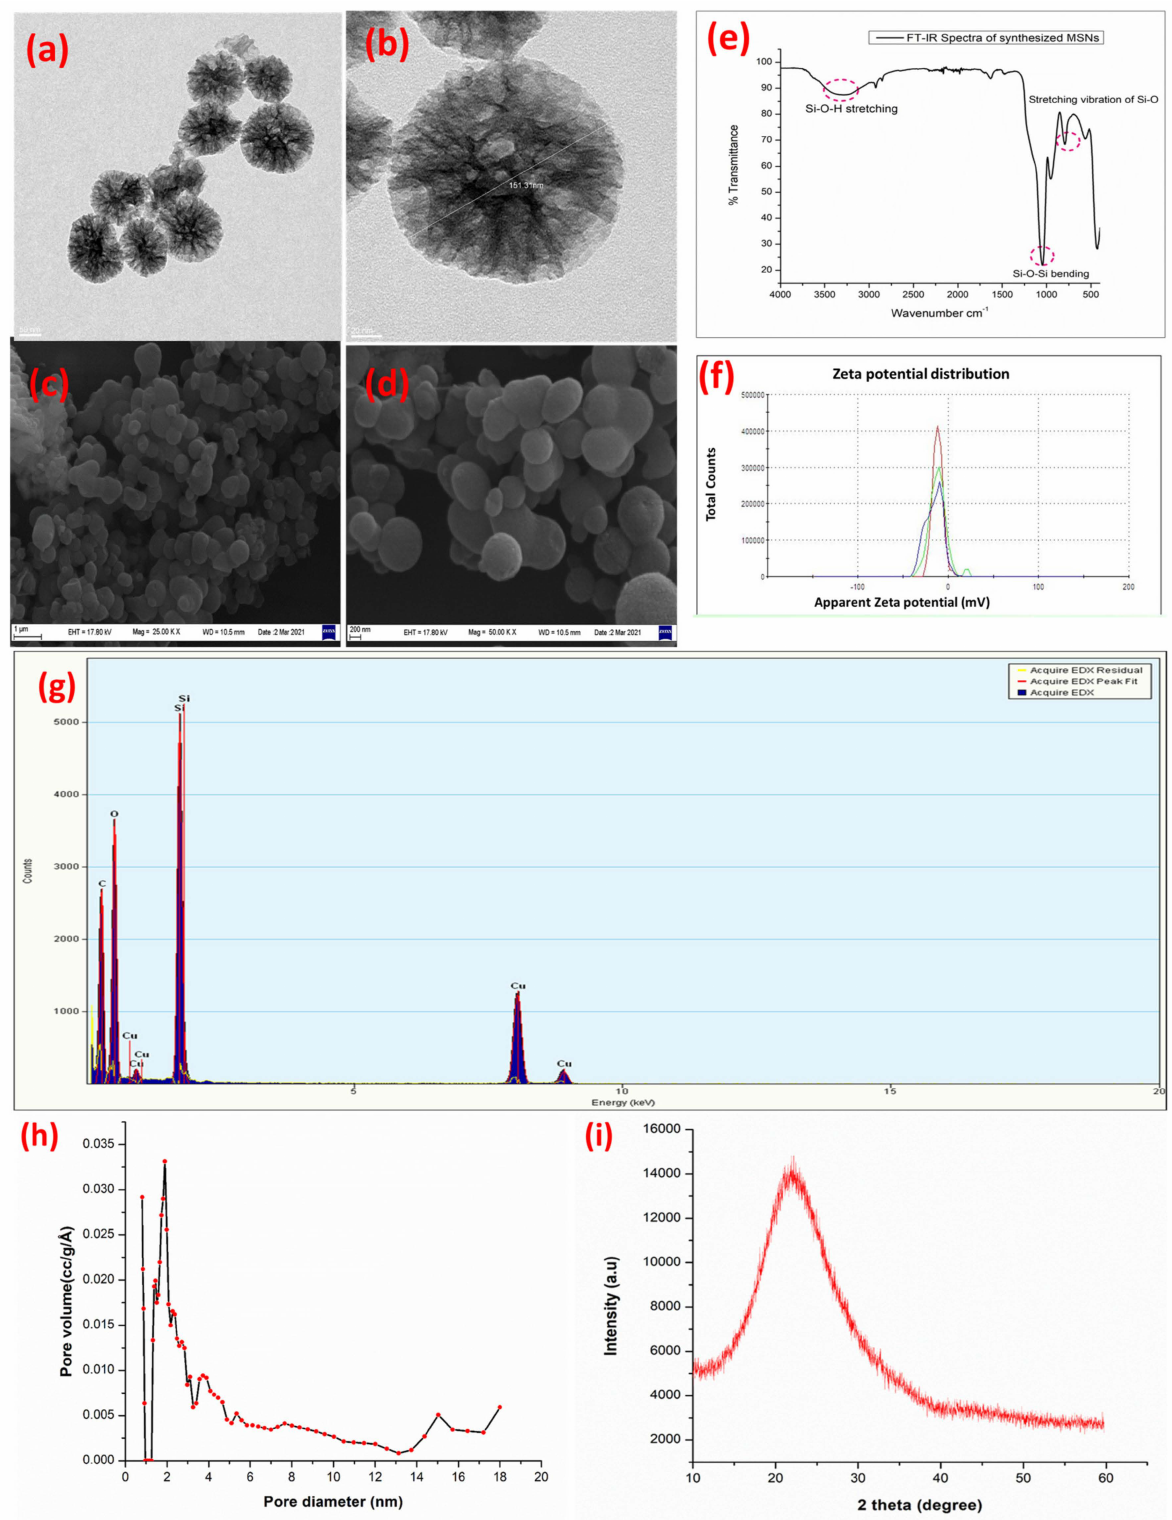
Figure 2. Characterization of synthesized MSNPs. ( a , b ): TEM morphological characterization; ( c , d ): SEM morphology; ( e ): FTIR measurements; ( f ): Zeta potential; ( g ): EDX confirmation for elemental composition; ( h ): XRD analysis; ( i ): BET